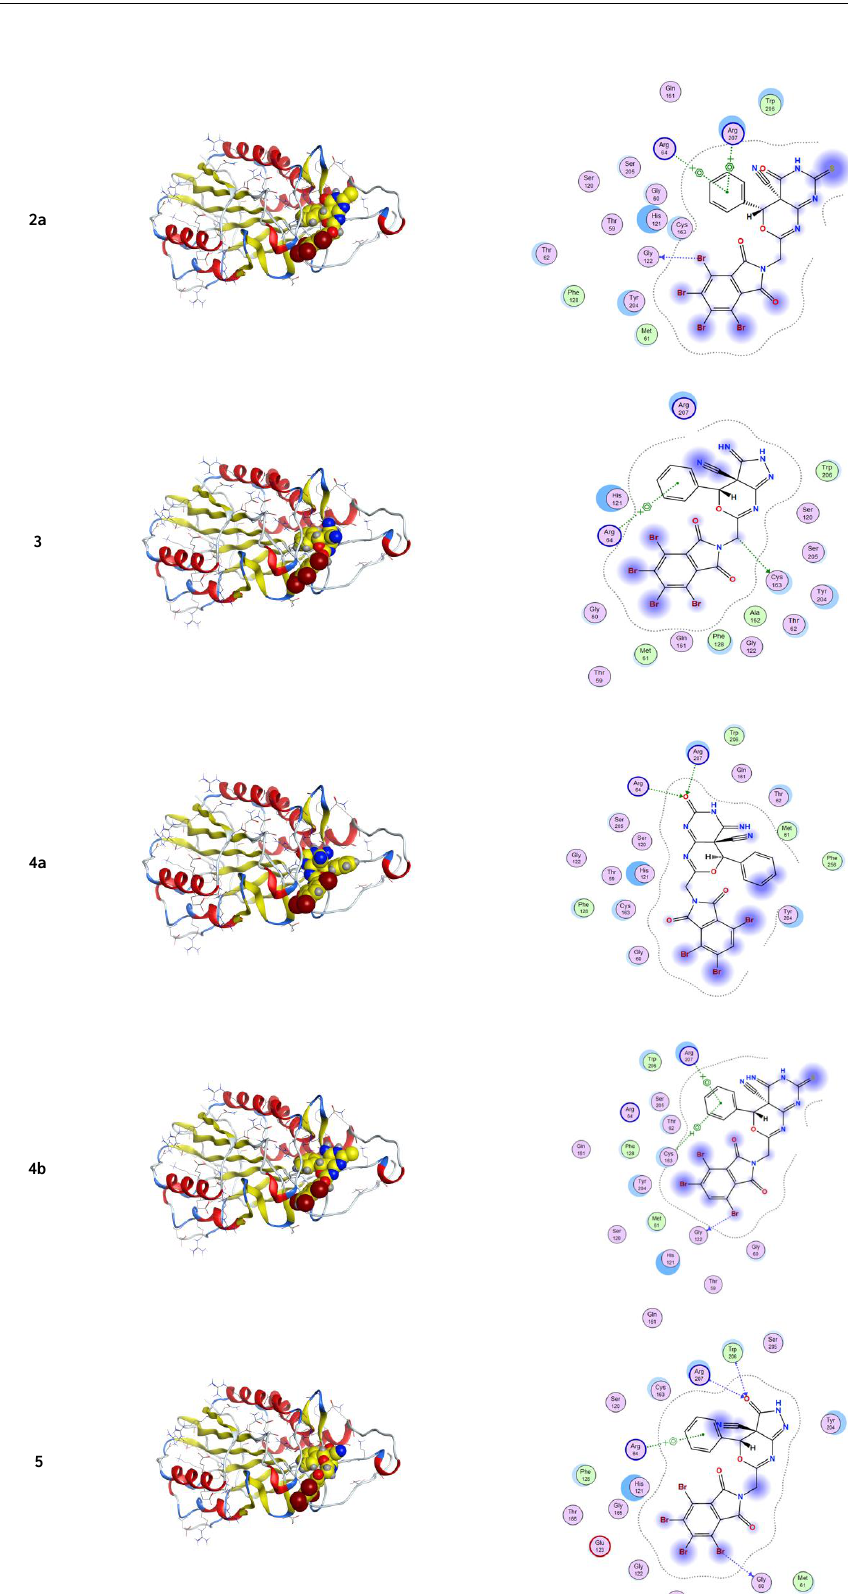
Figure 5. 3D and 2D snapshots showing the hydrophilicity interaction to HeLa caspase3 target receptor “V266”.